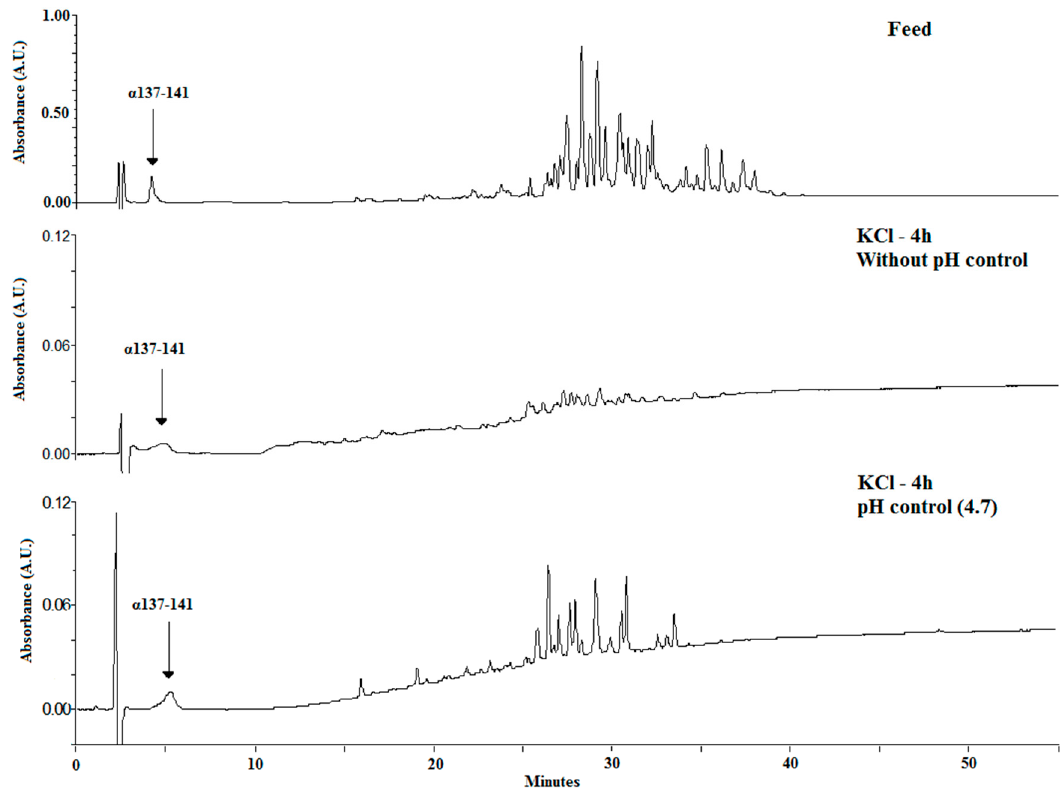
Figure 3. Chromatographic profiles of recovered total peptides after 4 h of EDUF treatment without and with pH control at 4.7.